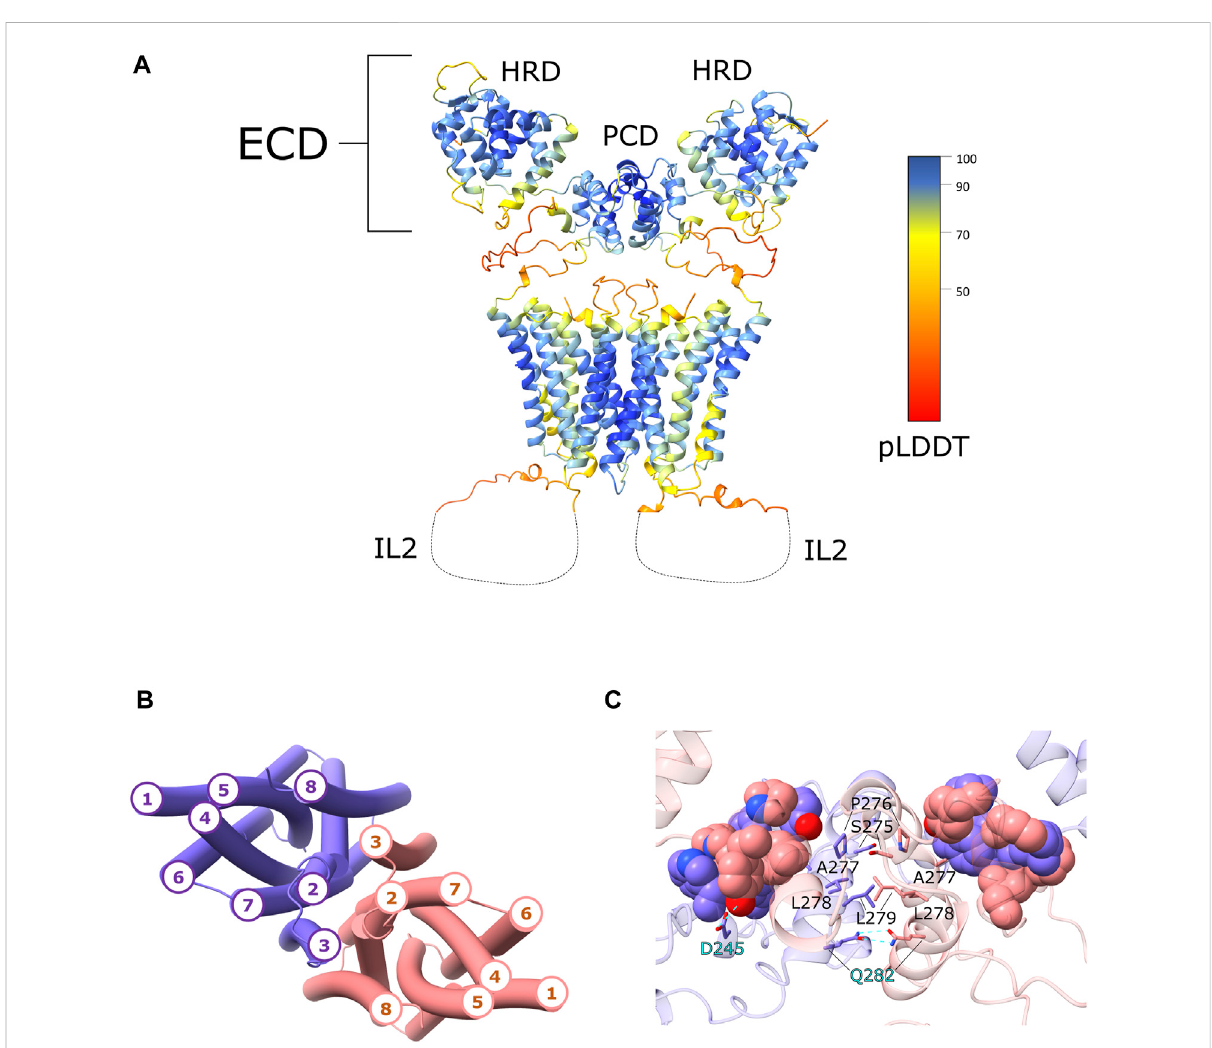
FIGURE 1 hZIP4 homodimer structural model. (A) The three-dimensional model of the hZIP4 homodimer, obtained with AlphaFold-Multimer v2.2.0, is depicted with ribbon representation and colored by pLDDT score. For clarity the long IL2 loop was removed and represented with a dashed line. (B) The topology of the eight transmembrane α -helices is here presented. The two chains are colored in purple (chain A) and pink (chain B), in order to distinguish the two monomers. (C) Close up on the PCD domain, where the interacting residue of the PAL motifs were represented as sticks. The residues involved in hydrogen bond interactions are represented as sticks and highlighted with cyan labels. The hydrophobic residues forming the hydrophobic core between the two monomers are represented as sphere and colored in purple (chain A) and in pink (chain